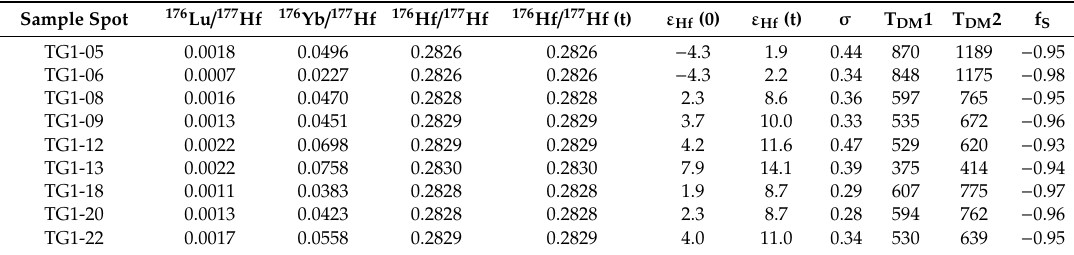
Table 3. Zircon Lu-Hf isotopic data from the TMG.